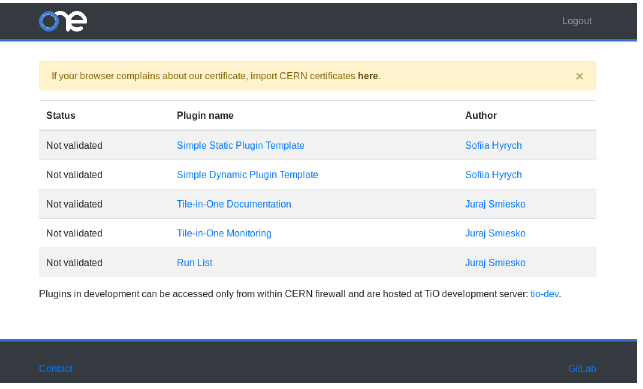
Figure 5. Screenshot of the user interface of the main Tile-in-One server. The figure shows main server for finished